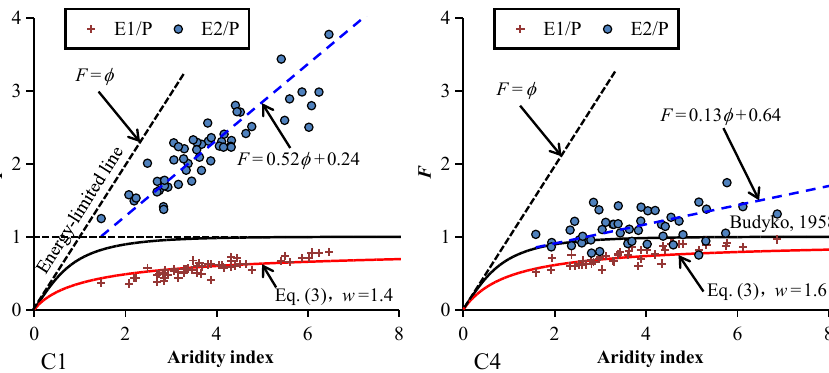
Figure 8. Plots of the F − ϕ data in the standard Budyko space using the E 1 data for Zone-1 and the E 2 data for Zone-2 that estimated with Eq. (19) in catchments C1 (left) and C4 (right). The red curves are the Budyko curves determined with Eq. (3), which could approximately represent the variations of the E 1 /P data. The dashed blue lines are the linear regression lines of the E 2 /P